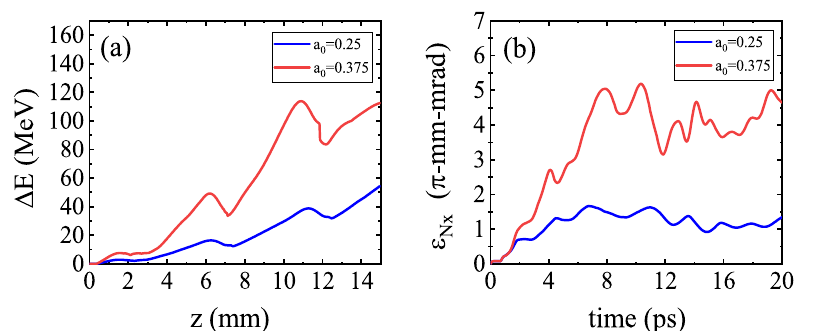
Figure 10. (a) Variation of the maximum energy gain (cid:31) E as a function of distance, and (b) bunch emittance ǫ N,x as a function of the propagation time for two initial pulse amplitudes of a 0 cases, the initial energy of electrons is E 0